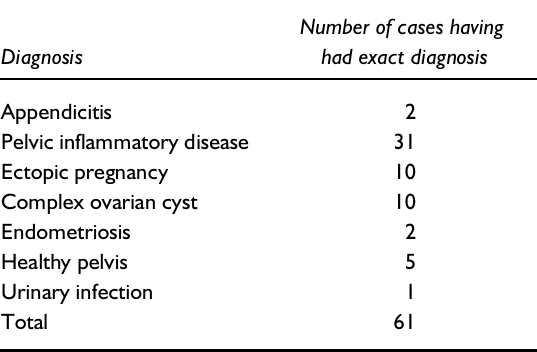
Table 2 Exact diagnosis in patients having